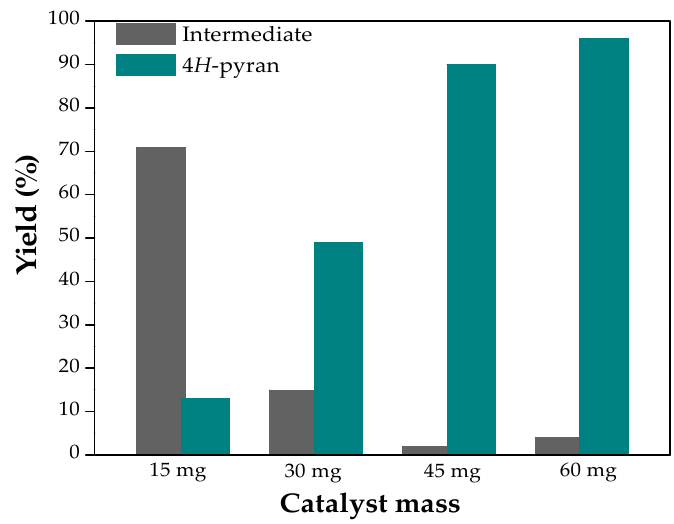
Figure 5. Effect of catalyst amount. Reaction conditions: benzaldehyde (1 mmol), ethyl acetoacetate (1 mmol), malononitrile (1 mmol), solvent-free, 8 h, 353 K.